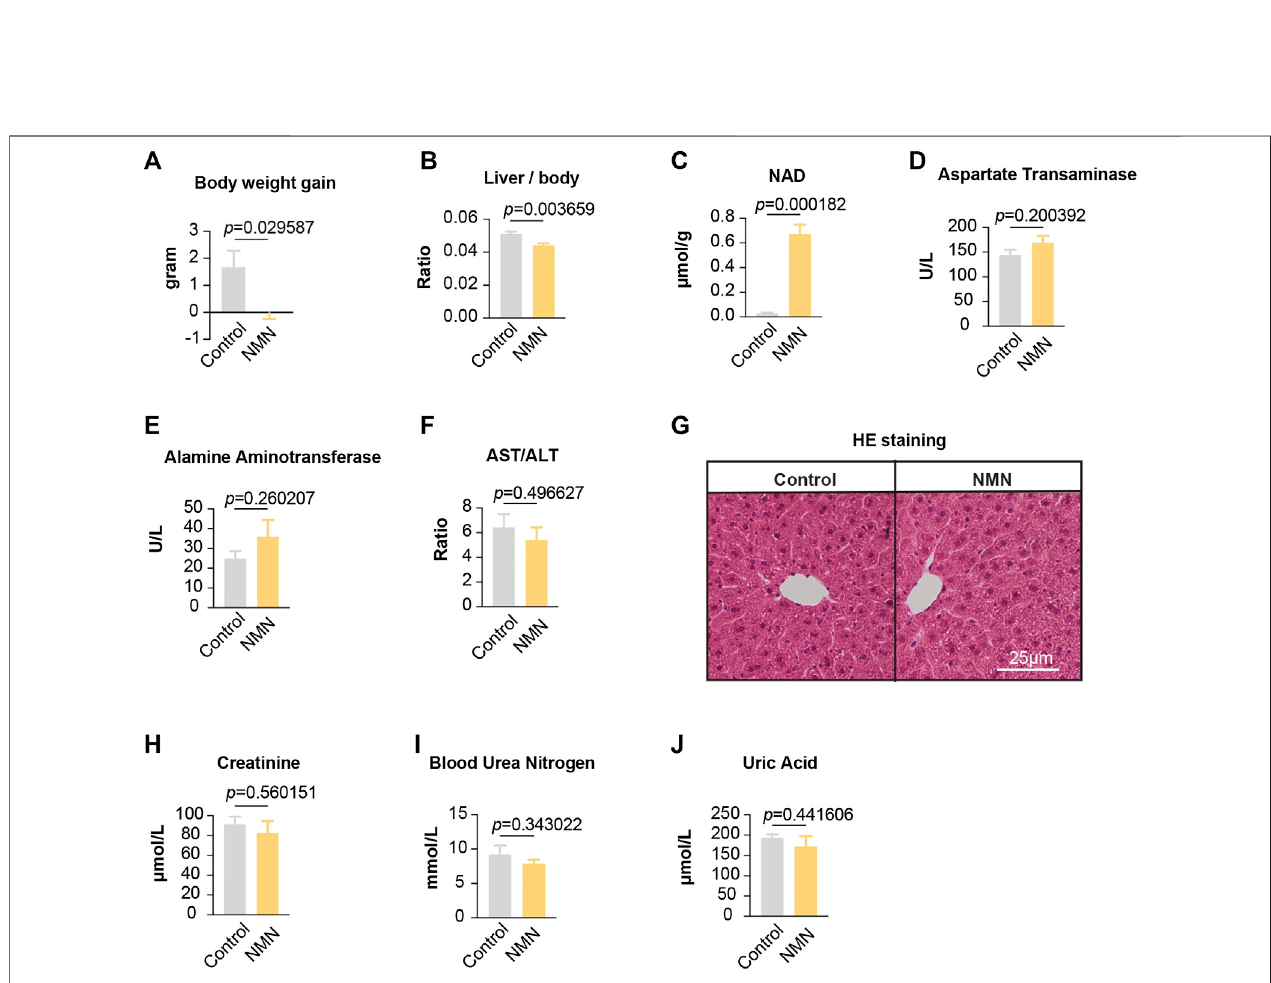
FIGURE 2 | Data for mice treated with NMN once per day (A) The body weight was decreased after NMN administration. (B) The ratio between liver weight and body weight was decreased after NMN administration (C) Liver NAD + levels were increased after NMN administration. (D – F) Liver function was analyzed after NMN administration. (G) PhotomicrographofliversectionsfromNMN-administeredmiceexhibitednormalhepatocytes (H&Estain). (H – J) Kidneyfunctionwereanalyzedafter NMN administration.